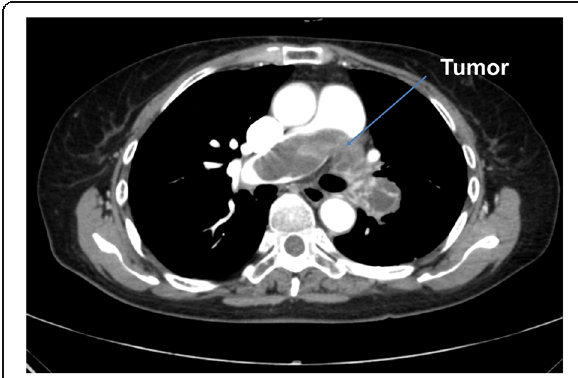
Fig. 1 A tumor in the pulmonary artery was observed on chest computed tomography imaging. The mass filled the left pulmonary artery, from its distal portion and extended to the right pulmonary artery, which had minimal blood